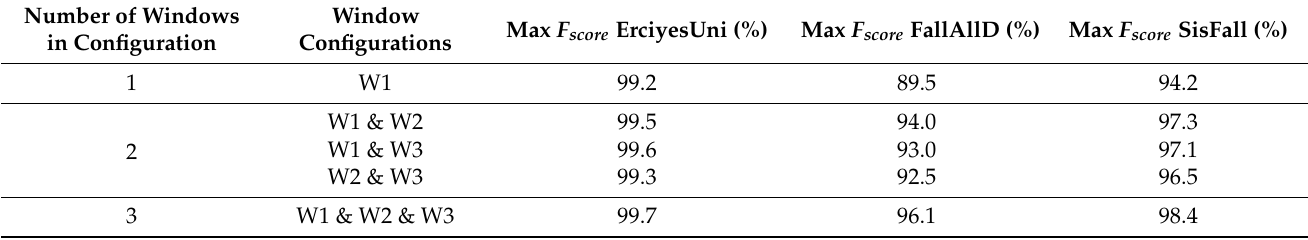
Table 3. The maximal F score achieved for each configuration of data segmentation window. Number of Windows in Configuration